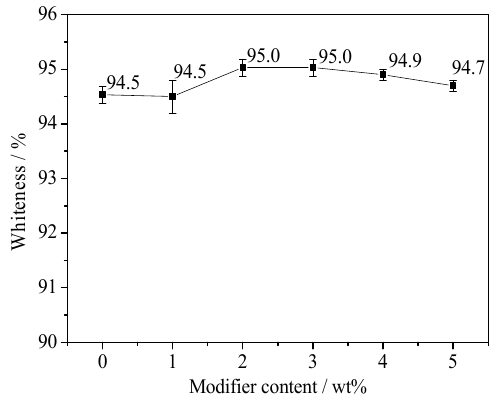
Figure 8. The change of whiteness of the samples as modifier content.